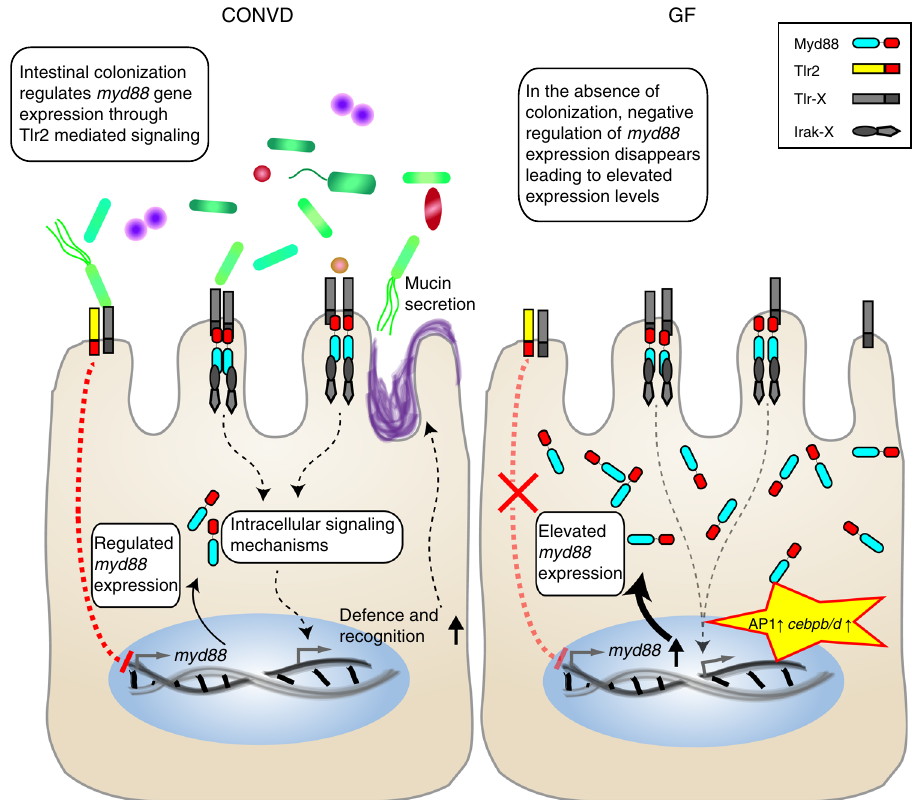
Fig. 5 Model of colonization-driven Myd88-dependent transcriptional feedback mechanism. In the normal colonized state (CONVD), one or more microbial associated molecular pattern(s) is perceived by Tlr2 in an, as yet, unidenti fi ed receptor constellation. The resulting intracellular signaling events have a suppressing effect on myd88 transcriptional activity, keeping the intracellular Myd88 concentration below what is permissible for it to induce ligand independent signaling events, yet still high enough for normal TLR stimulated responses to occur. Normal Tlr stimulated Myd88 dependent signaling leads to protective mucin secretion in the intestine. In the germ-free (GF) state, the absence of the Tlr2 mediated negative regulation of myd88 transcription leads to elevated intracellular concentrations, suf fi cient to drive ligand independent signaling including transcripts associated with a Tlr2 dependent ligand stimulated response such as those encoding AP1 transcription factors and CCAAT/enhancer binding mutant ( tlr2 sa19423 ) mutant fi sh was approved by the local animal welfare committee (DEC) of Leiden University (license number 10612, protocol 12232).